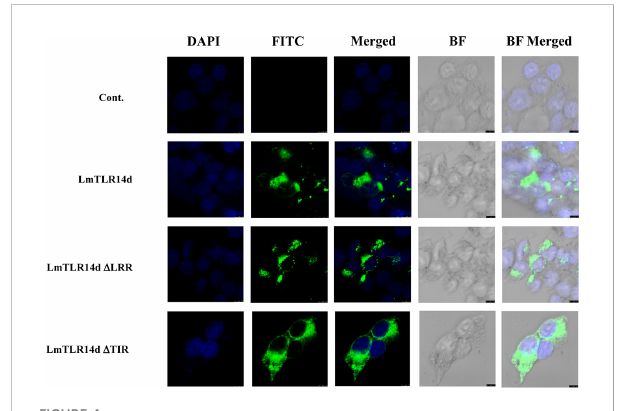
FIGURE 4 Localization of LmTLR14d, LmTLR14d D LRR and LmTLR14d D TIR in HEK 293T cells. DAPI stained nuclei (blue fl uorescence, DAPI fl uorescence channel), FLAG-tagged antibody labeled pCMV- LmTLR14d, pCMV-LmTLR14d D LRR and pCMV-LmTLR14d D TIR fusion protein (green fl uorescence, FITC fl uorescence channel), and bright fi eld observations. Empty plasmid (pCMV) was used as a control, the scale is shown in the fi